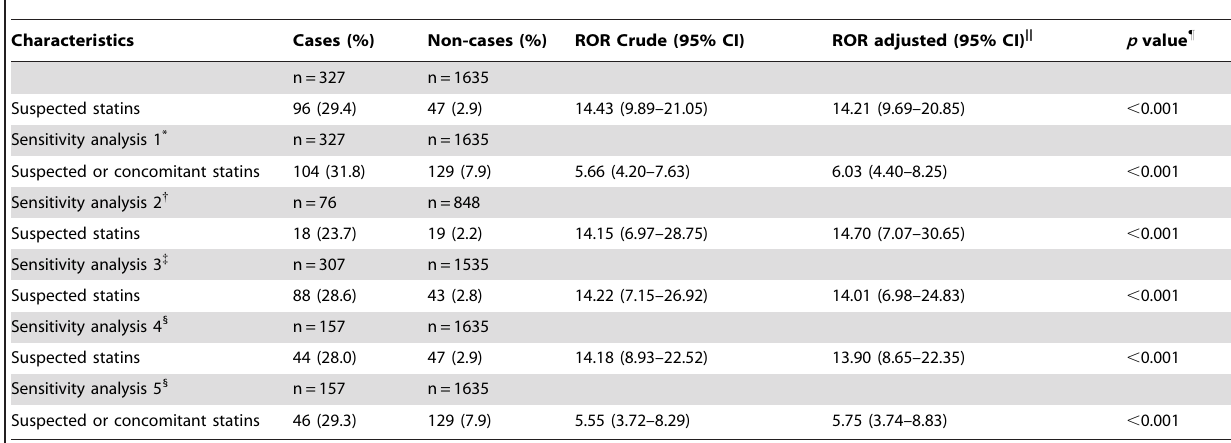
Table 3. Association between the use of statins and polymyalgia rheumatica (PMR).